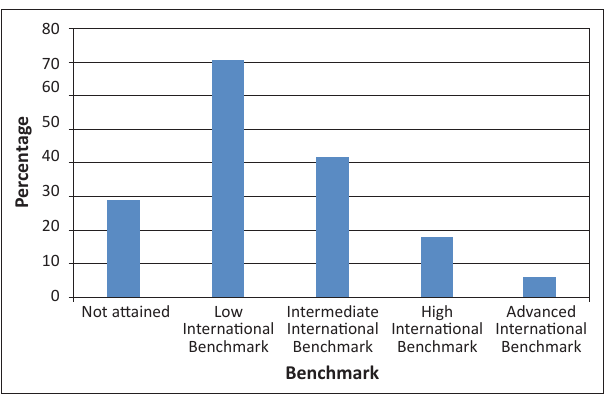
FIGURE 1: PrePIRLS 2011 overall benchmark